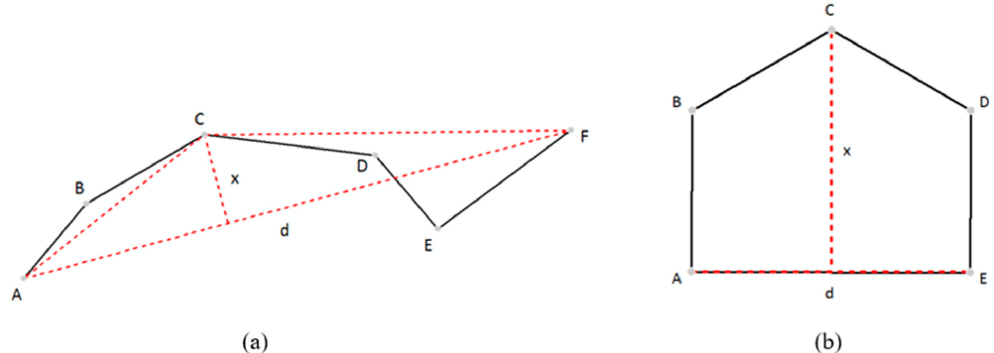
Figure 2. (Color online) Illustration of geometric measures for the ( a ) point-based simplifying unit (e.g., Douglas–Peucker (DP) algorithm) and ( b ) areal-based unit (e.g., bend simplify (BS) and hierarchical decomposition of a polygon (HD) algorithm).